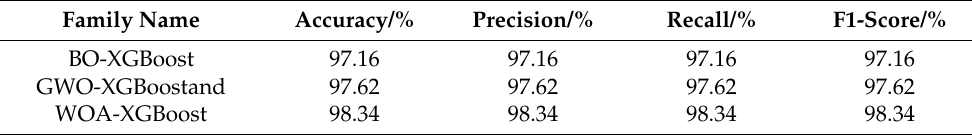
Table 3. Quantity Distribution of Sample DataCon Dataset.